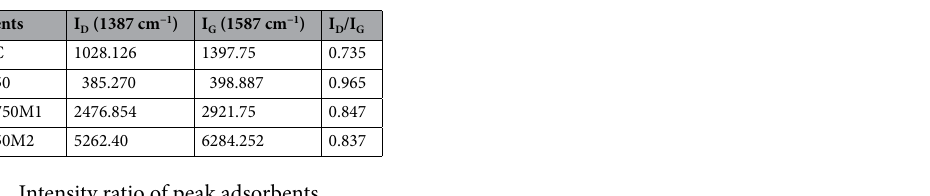
Table 5. Intensity ratio of peak adsorbents.